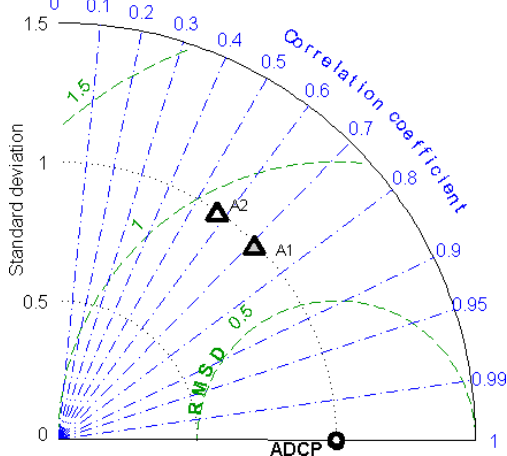
Figure 4. Taylor diagram comparing the error metrics between the observations and model results for the near-bottom currents. A1 and A2 correspond to the ADCP locations shown in Fig.